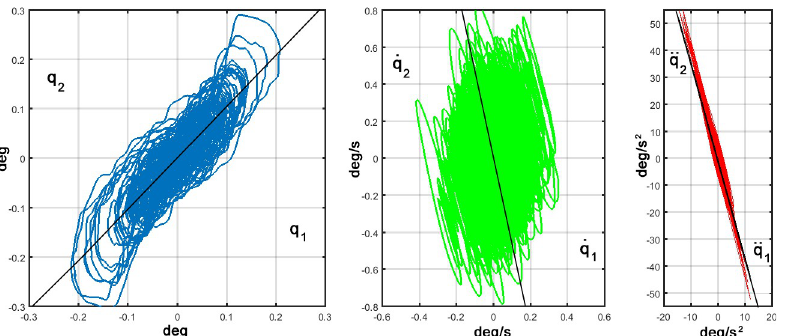
Fig 6. Coordination of Ankle ( q 1 ) and Hip ( q 2 ) oscillations from the simulation of the DIP/VIP hybrid model. The quantities showed are the angular rotations (left panel), the angular velocities (central panel) and the angular accelerations (right panel). The plotted traces correspond to a 60 s sway.